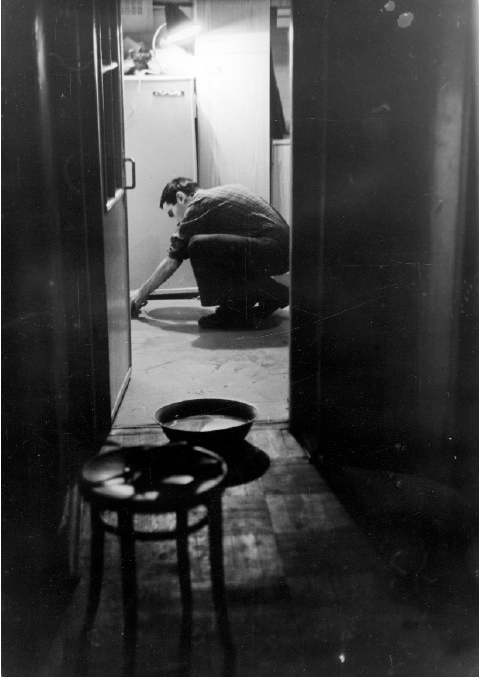
Figure 15. Albert. From the series Household Help . 1981. Black-and-white photograph. Image courtesy of Yuri Albert. Photograph by Sven Gundlach.